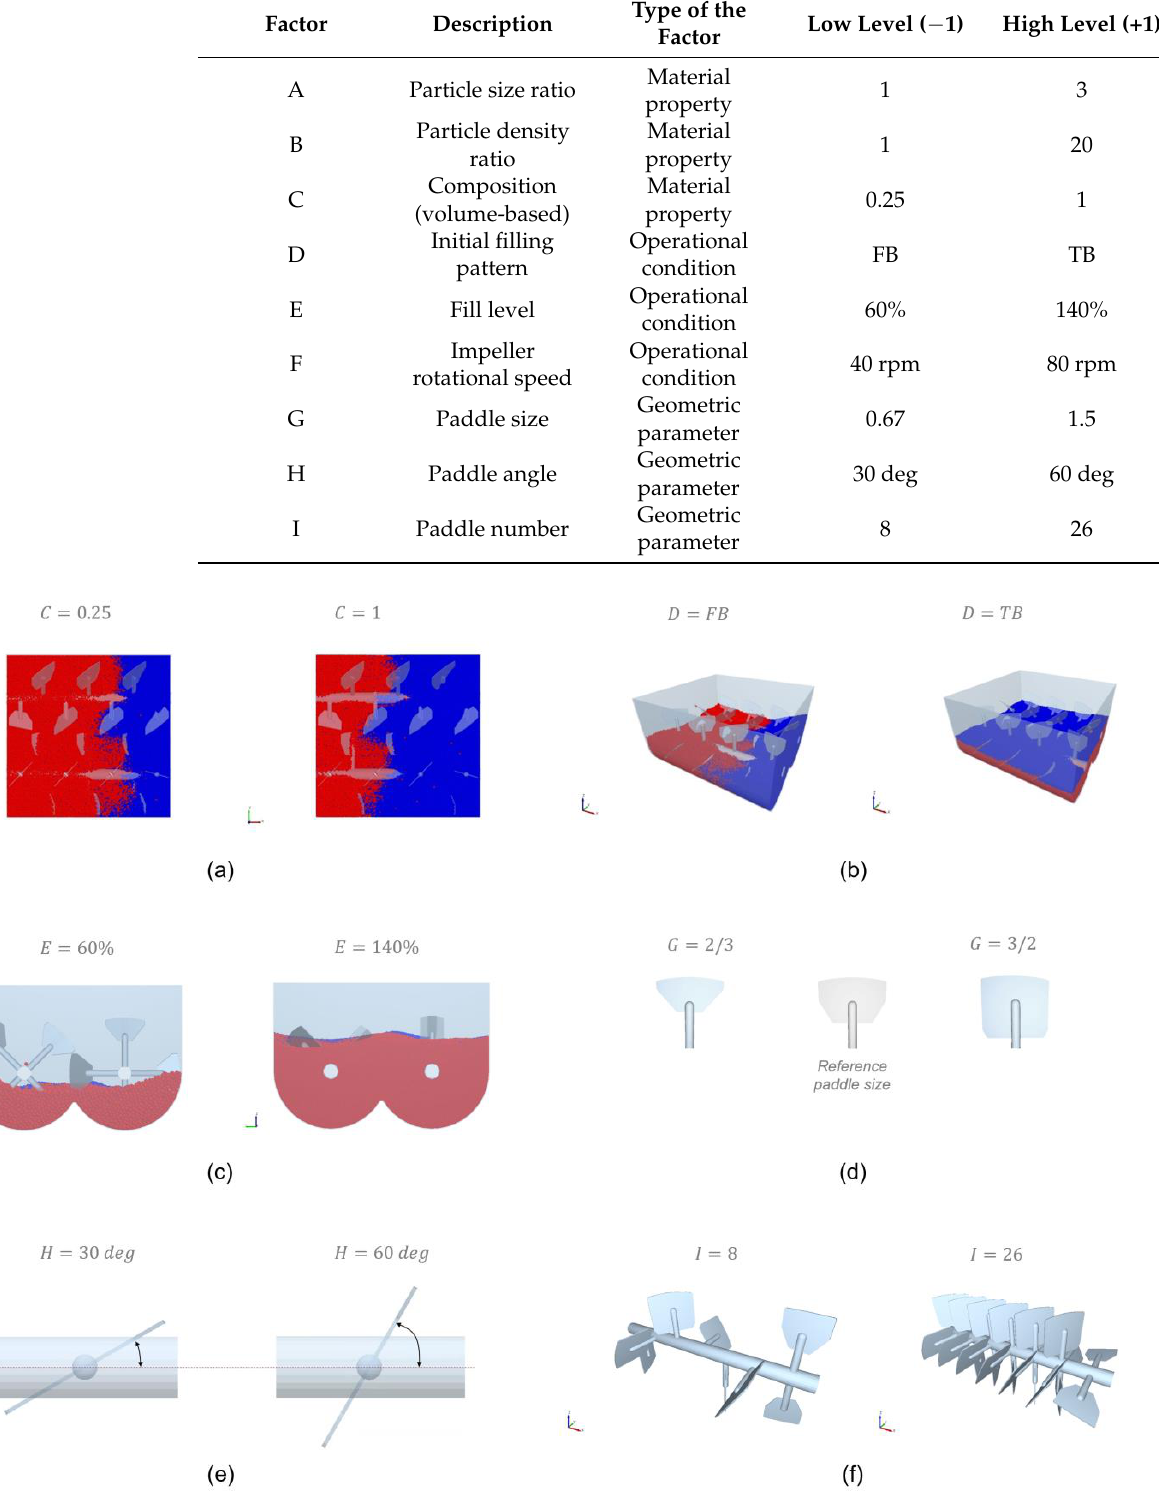
Table 3. Factors with corresponding levels for the Plackett–Burman (P–B) Design of Experiments (DoE).